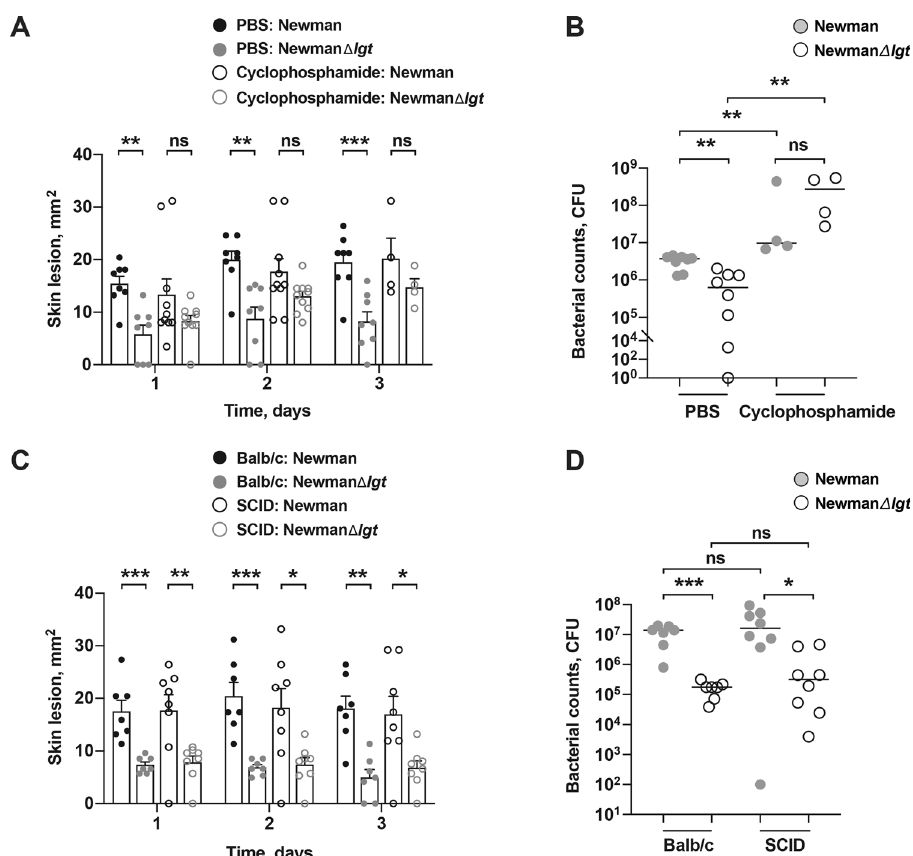
Fig. 6 Difference in bacterial clearance between the parental- and Δ lgt mutant strain disappears by leukocyte depletion. The skin lesion size (mm 2 ) in mice ( n = 8 – 10/group) up to 3 days ( A ) and bacterial counts in the supernatant of skin biopsy homogenates ( B ) from the surviving mice ( n = 4 – 8/group) on day 3 after subcutaneous (s.c.) skin injection with 20 μ l of Staphylococcus aureus Newman parental strain or Newman Δ lgt mutant strain (2 × 10 6 colony- forming units [CFU]/site) in NMRI mice depleted of leukocytes using cyclophosphamide or treated with phosphate-buffered saline (PBS) as control. The skin lesion size (mm 2 ) up to 3 days ( C ) and bacterial counts in the supernatant of skin biopsy homogenates ( D ) on day 3 after s.c. skin infection with Newman parental strain or Newman Δ lgt mutant strain (2 × 10 6 CFU/site) in SCID mice or Balb/c controls ( n = 7 – 8/group). The data were pooled from two independent experiments. Statistical evaluations were performed using the Mann – Whitney U test, with data expressed as the mean ± standard error of the mean ( A , C ), or presented as scatterplot with line indicating median value ( B , D ). * P < 0.05; ** P < 0.01; *** P < 0.001; ns = not signi fi